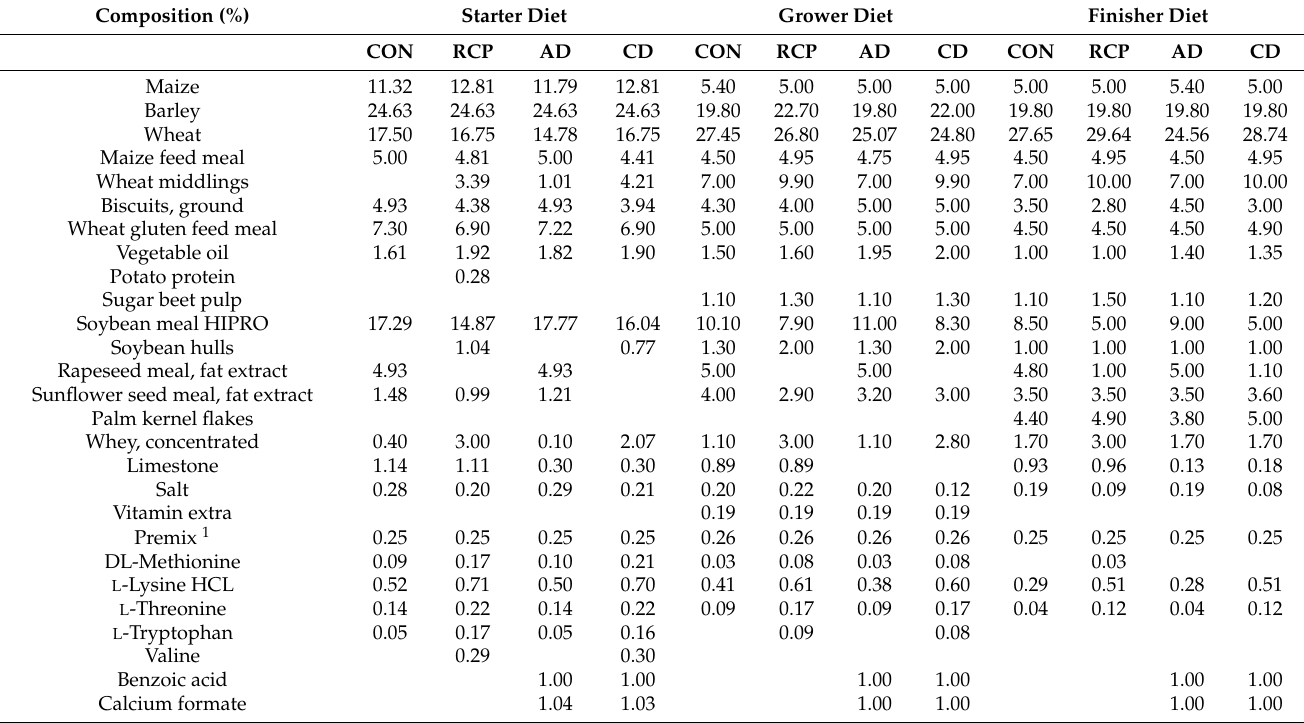
Table 1. Ingredient composition of experimental diets, as-fed basis.